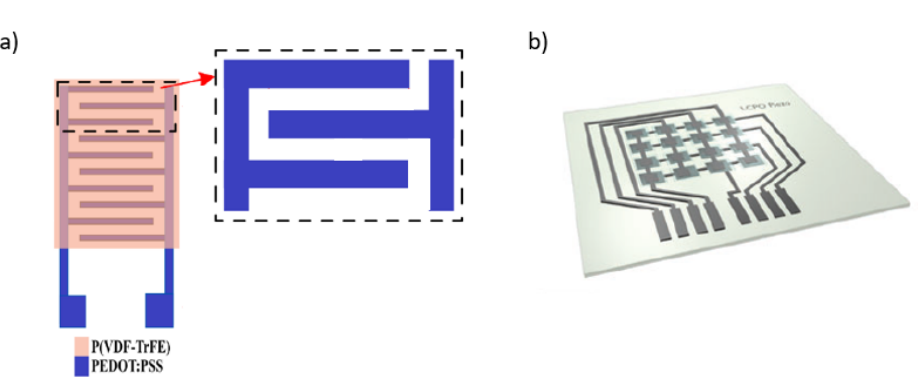
Figure 8. Schematic illustration of printed piezoelectric sensors: ( a ) [134] and ( b )